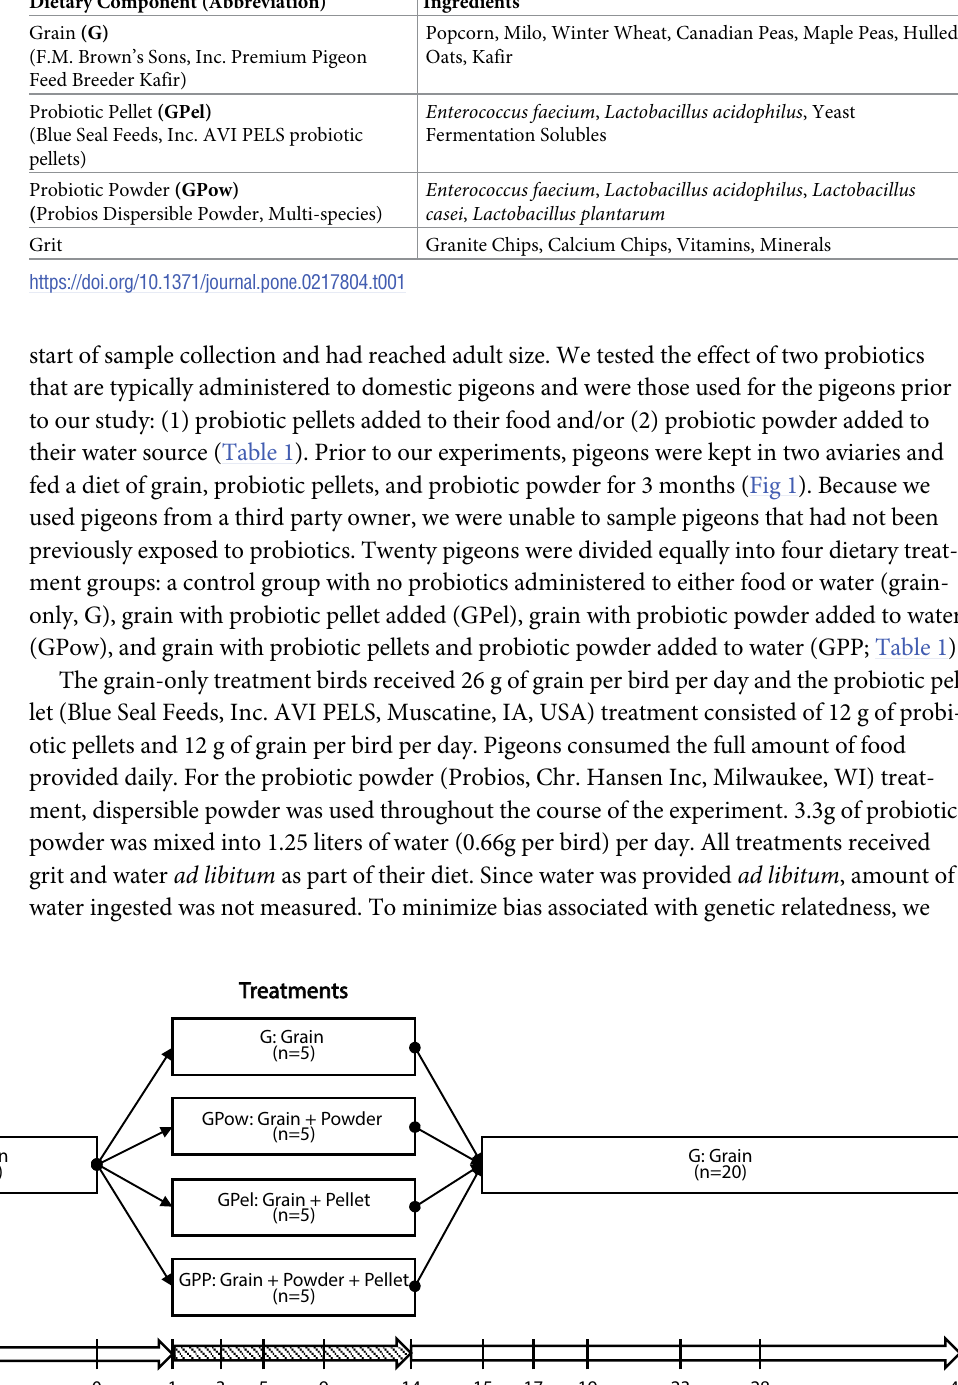
PLOS ONE | https://doi.org/10.1371/journal.pone.0217804 June 17,